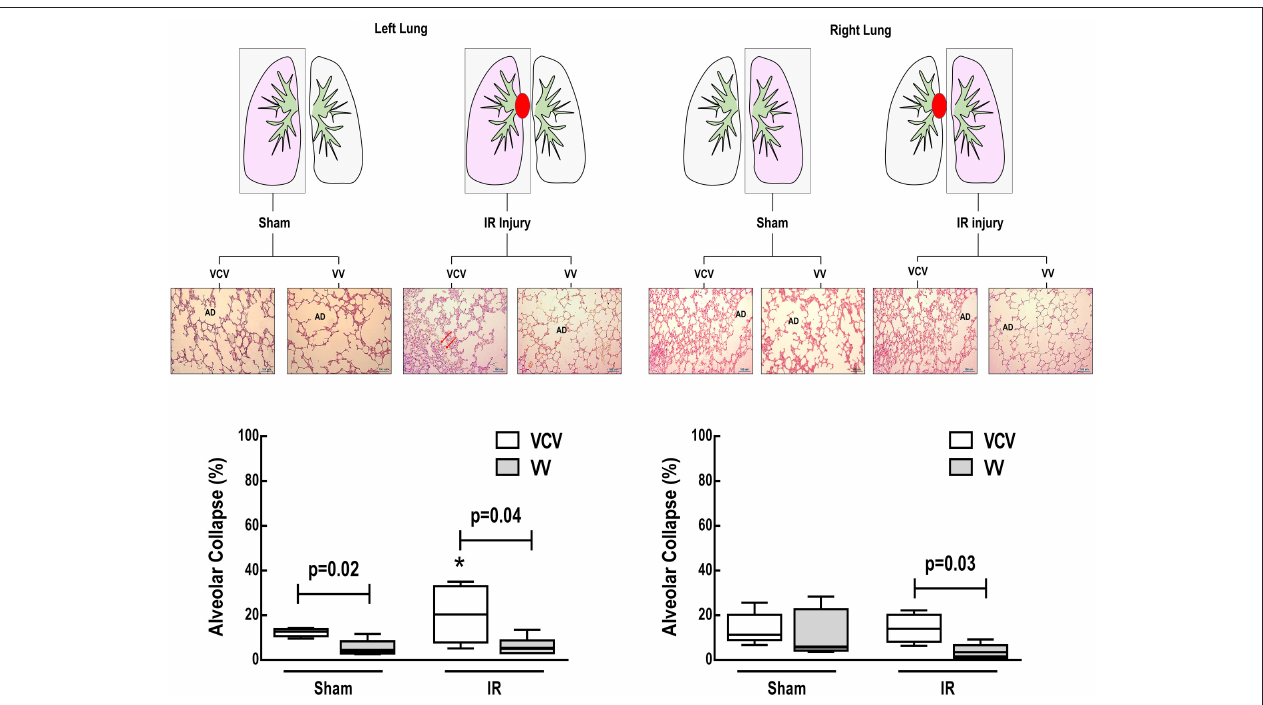
FIGURE 2 | Schematic representation of lung ischemia-reperfusion (IR) injury and sham clamping in left (injured) and right (contralateral) lungs, in animals ventilated in volume-controlled (VCV) or variable controlled ventilation (VV). AD: Alveolar duct. Photomicrographs of lung parenchyma stained with hematoxylin-eosin, original magnification x200. Arrows: alveolar collapse. Fraction areas of alveolar collapse in left and right lungs of Sham and IR animals ventilated with VCV and VV. Values represent medians and whiskers represent the 10–90 percentile range of 6 animals in each group. Two-way repeated-measured ANOVA followed by Bonferroni’s post-hoc test ( p < 0.05). *Significantly different from Sham group ( p <